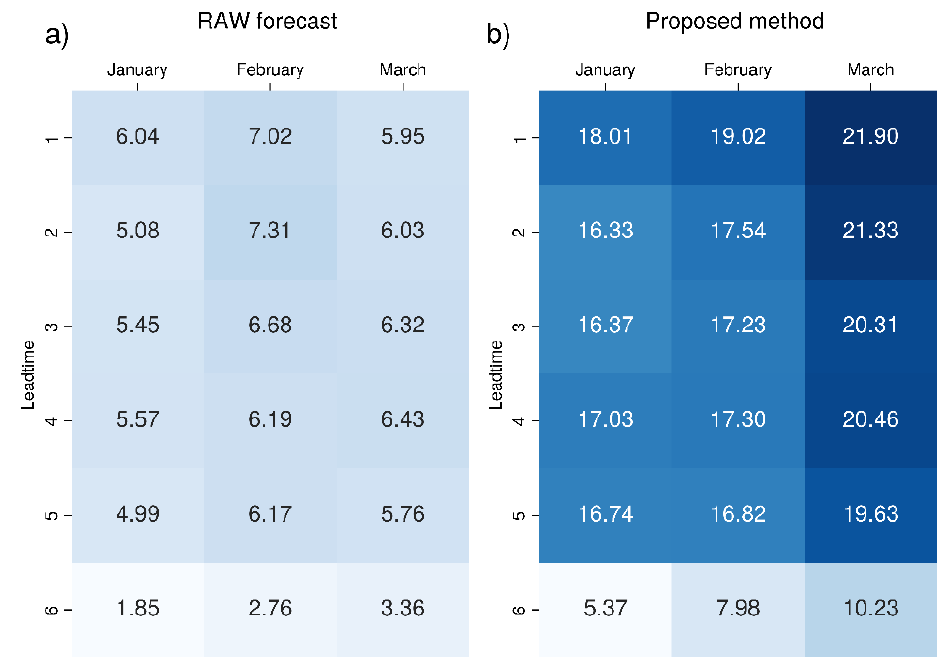
Figure 11. Mean percentage of ensemble members correctly predicting 2 m mean temperature over the 99th percentile value for seasonal forecast SEAS5 (ECMWF): ( a ) raw data and ( b ) data corrected with the proposed bias correction method. The colour scale ranges from white (0%) to dark blue, increasing in intensity as the percentage increases. The most intense colour corresponds to the max- imum value (in this case, 21.9% for March and lead time one).